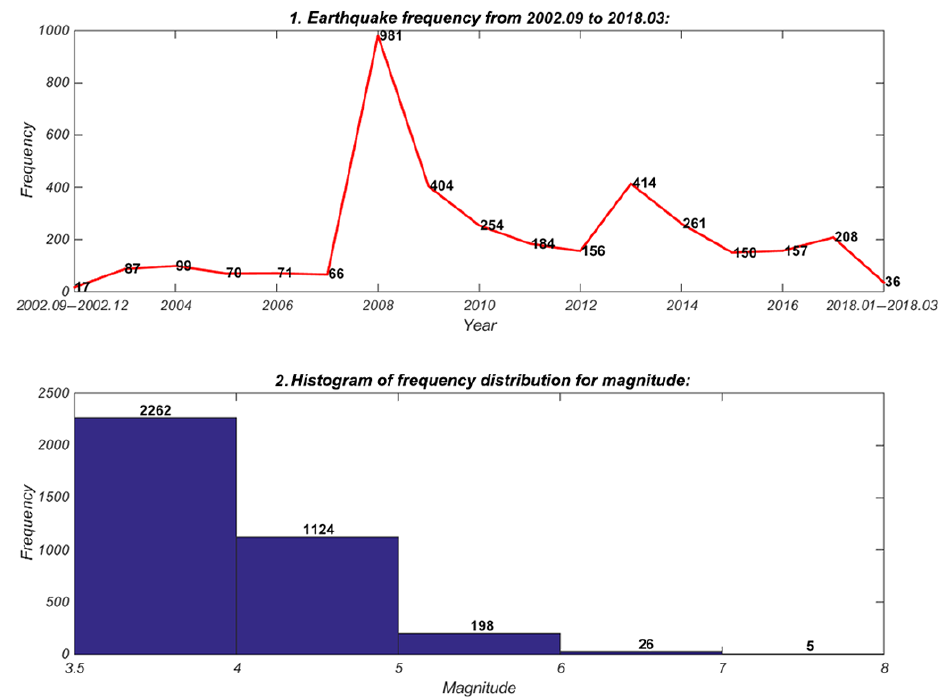
Figure 2. The temporal distribution from September 2002 to March 2018 of earthquakes with M ≥ 3 . 5 in the study area and the distribution of seismic frequency with earthquake